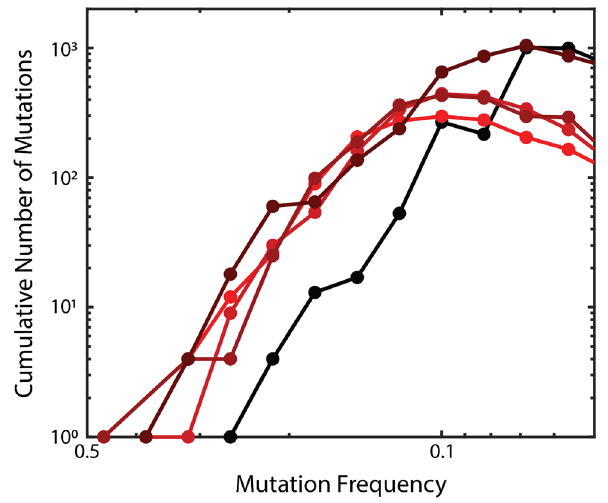
Figure 4. Cumulative number of mutations identified relative to the BL21-AI complete genome sequence (Accession NZ_CP047231.1, GI: 1797637028) for the BL21-AI negative control (black) and four replicates of BL21-AI subjected to the GENEWRITE